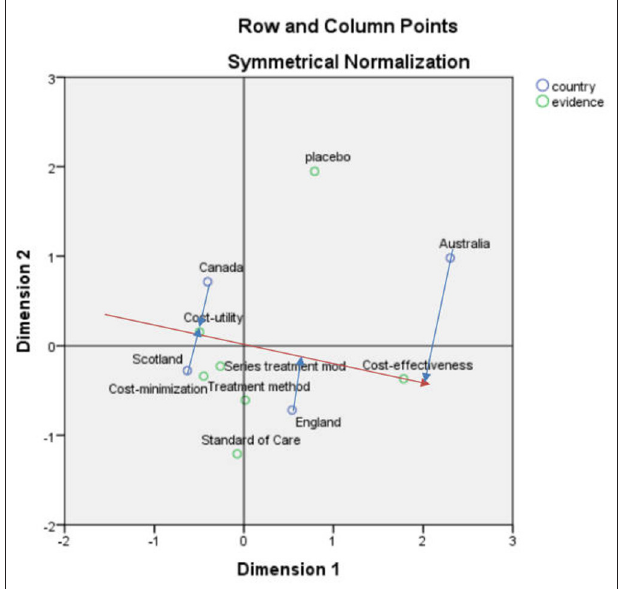
FIGURE 2 | Scatterplot of country and economic model correspondence analysis.